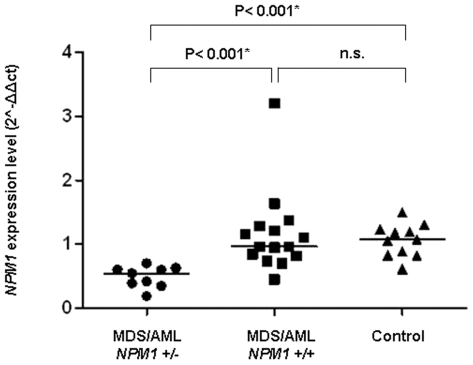
RT-qPCR and NPM1 gene expression.
NPM1 expression in 9 patients with MDS/AML NPM1+/− (median: 0.5443; range: 0.18÷0.70), in 15 with MDS/AML NPM1+/+ (median: 0.96; range: 0.44÷3.20) and in 11 healthy controls (median 1.07; range 0.61÷1.50). Horizontal lines indicate median NPM1 expression in each group. Y axis  = 2∧−ΔΔCt value (NPM1 gene expression level normalized to endogenous ABL1 gene) ΔCt = Ct NPM1 −Ct ABL1, ΔΔCt =  ΔCt sample−ΔCtcalibrator. (P values according to the Mann-Whitney U test and Bonferroni correction); n.s. =  non significant.